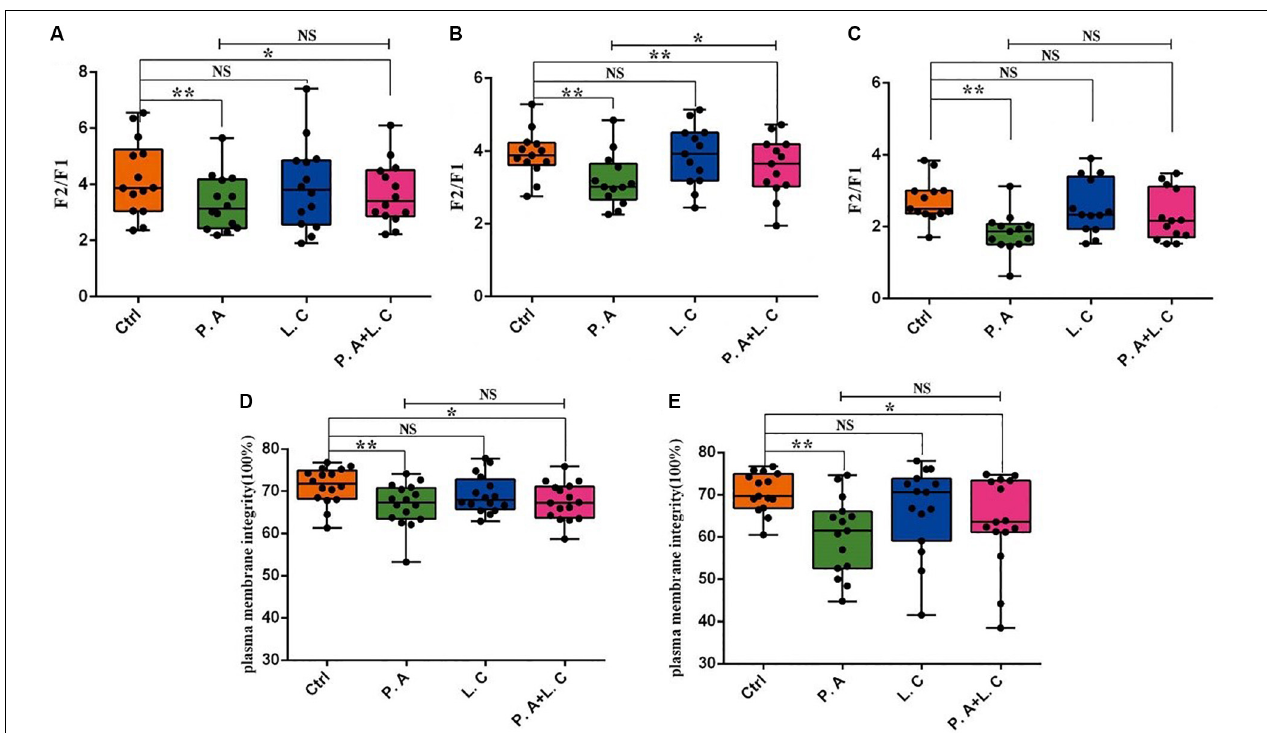
FIGURE 8 | Dominant bacteria impact on boar sperm mitochondrial activity and plasma membrane integrity in vitro preservation. The mitochondrial activity was determined on Day 3 (A) , Day 5 (B) , and Day 7 (C) , as well as plasma membrane integrity on Day 5 (D) and Day 7 (E) . Ctrl, control group; P.A, Pseudomonas aeruginosa treatment group; L.C, Lactobacillus casei treatment group; P.A + L.C, Pseudomonas aeruginosa with Lactobacillus casei treatment group. As mean ± SEM, the * means significant differences ( P < 0.05), and the ** means highly significant differences ( P < 0.01) between treatments at the same day; NS means not significant differences ( P > 0.05). A total of 14 semen samples were used as biological